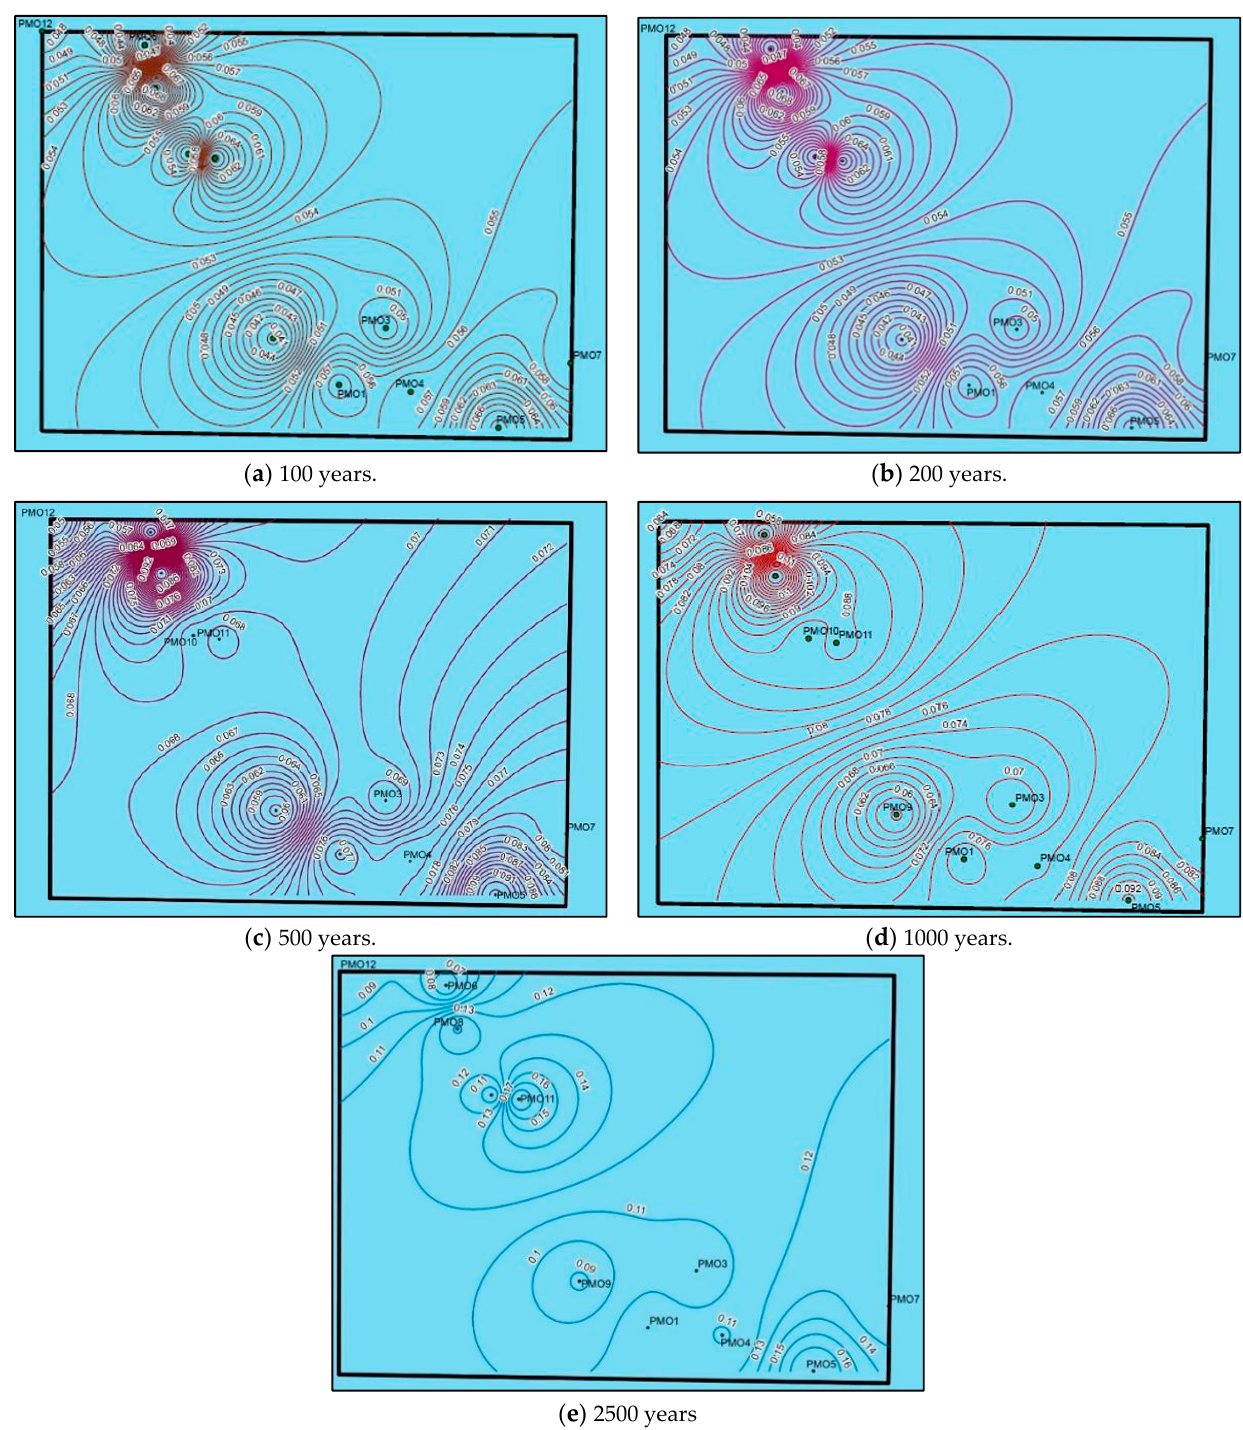
Figure 8. Seismic microzonation map for a 100-year return period.